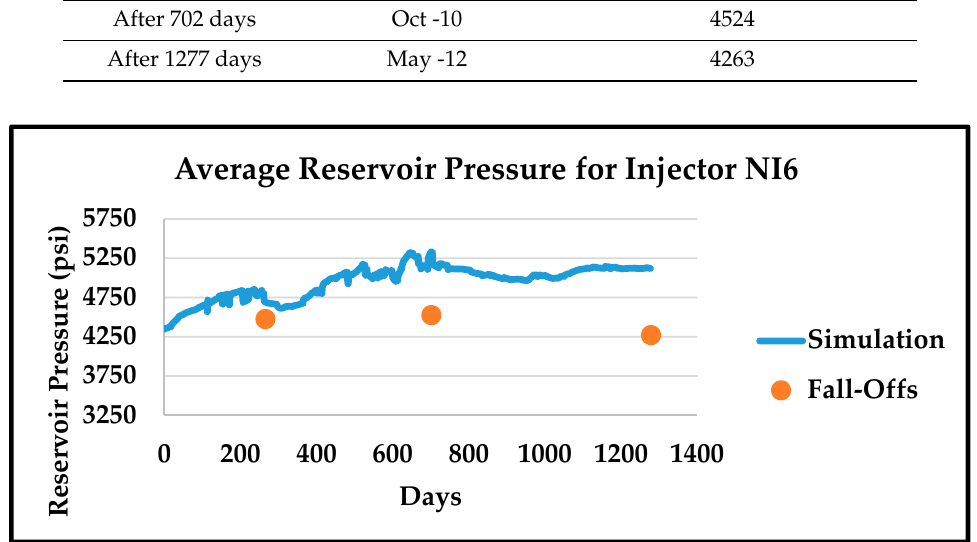
Table 1. Average Reservoir Pressure Measured by Long-term Fall off-Tests for Well NI6.